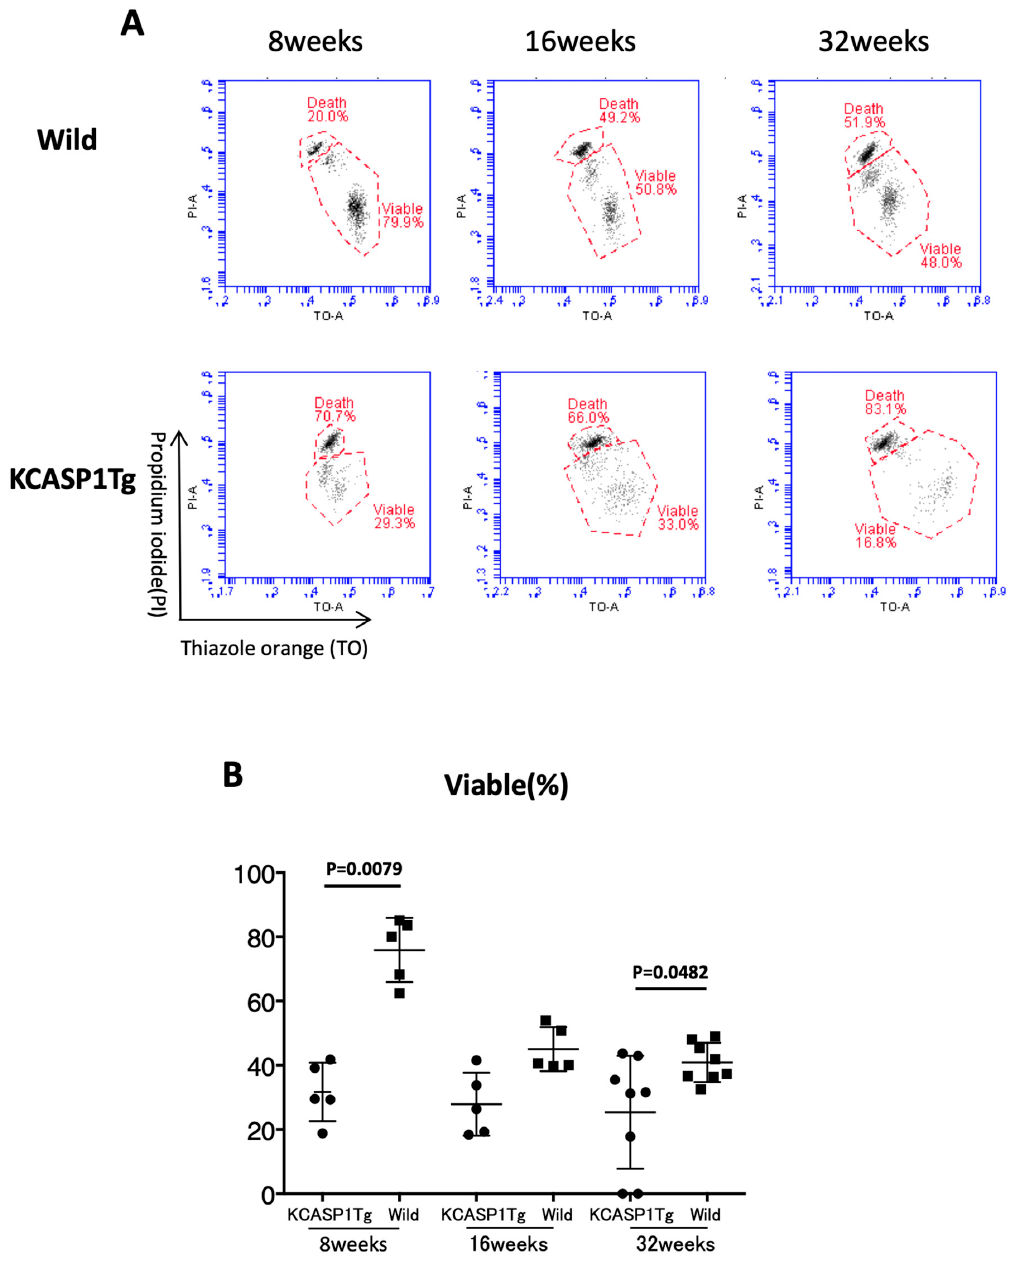
Figure 5. Sperm viability. The representative FCM data for the percentages of viable sperm cells at 8, 16, and 32 weeks of age in KCASP1Tg mice and wild-type mice are shown. Wild-type mice at 8 and 32 weeks of age showed a significantly larger number of viable sperm than KCASP1Tg mice ( p = 0.0079 and p = 0.0482, respectively, A , B ).